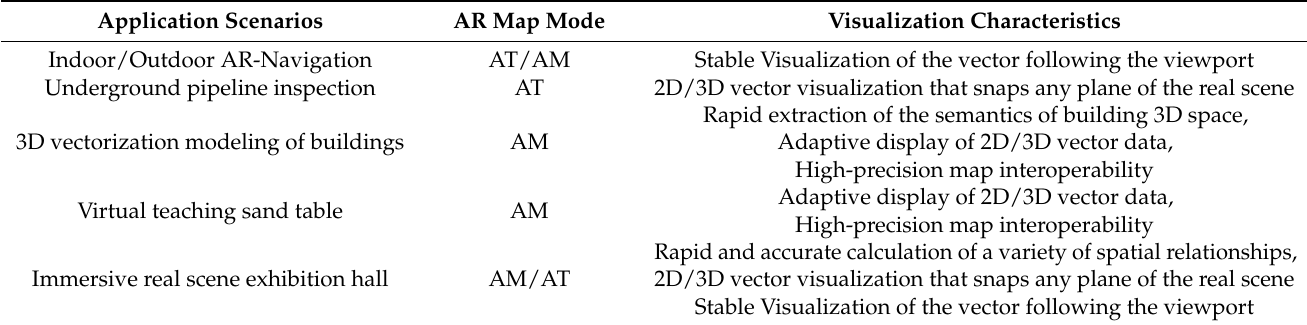
Table 8. AR map mode and visualization characteristics of some typical application scenarios supported in our